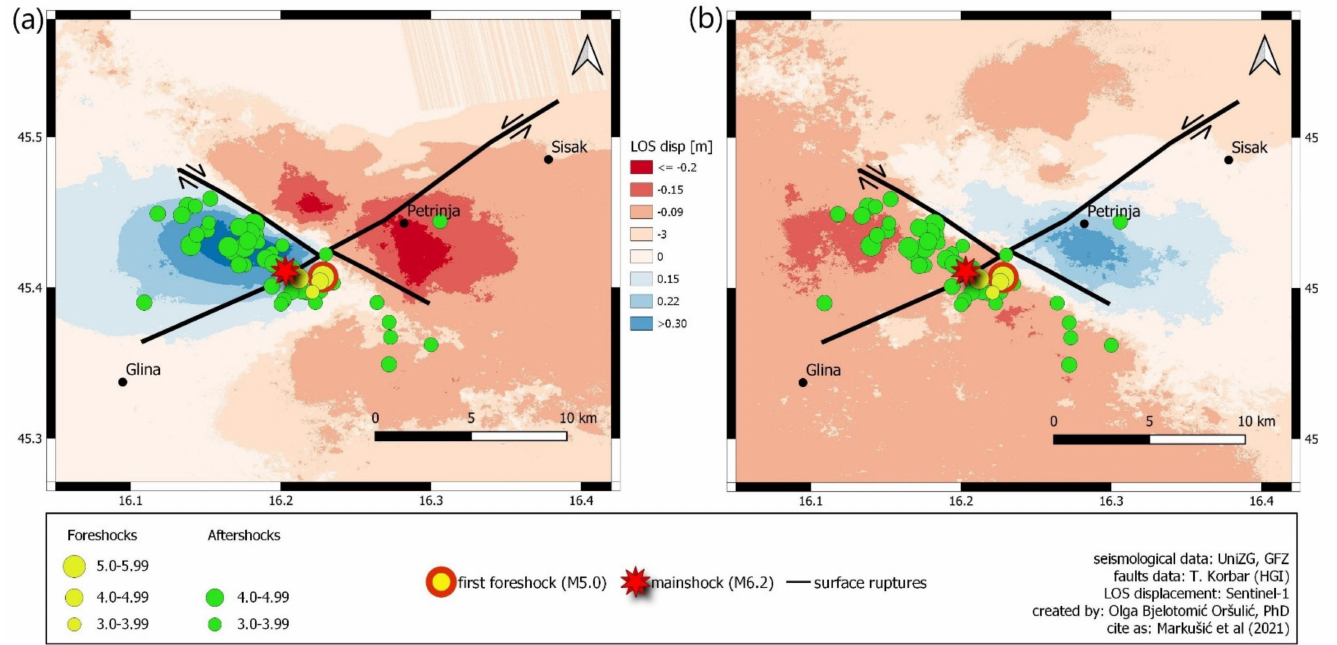
Figure 8. Line of sight (LOS) displacements for ( a ) Sentinel-1A ascending orbit T146, which has an amplitude of 74 cm and ( b ) Sentinel-1B descending orbit T124, which has an amplitude of 53